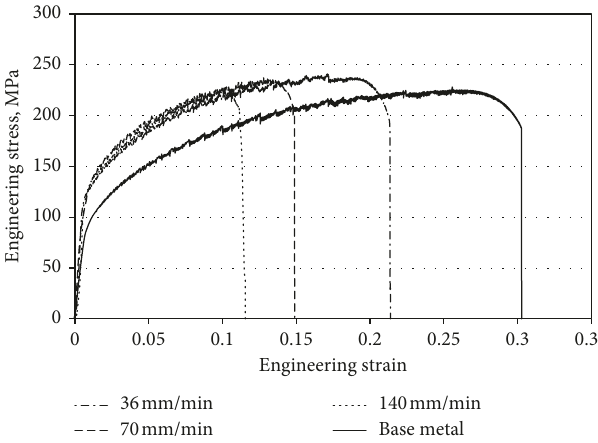
Figure 14: Engineering stress-strain curves of BM and friction stir welded joints of